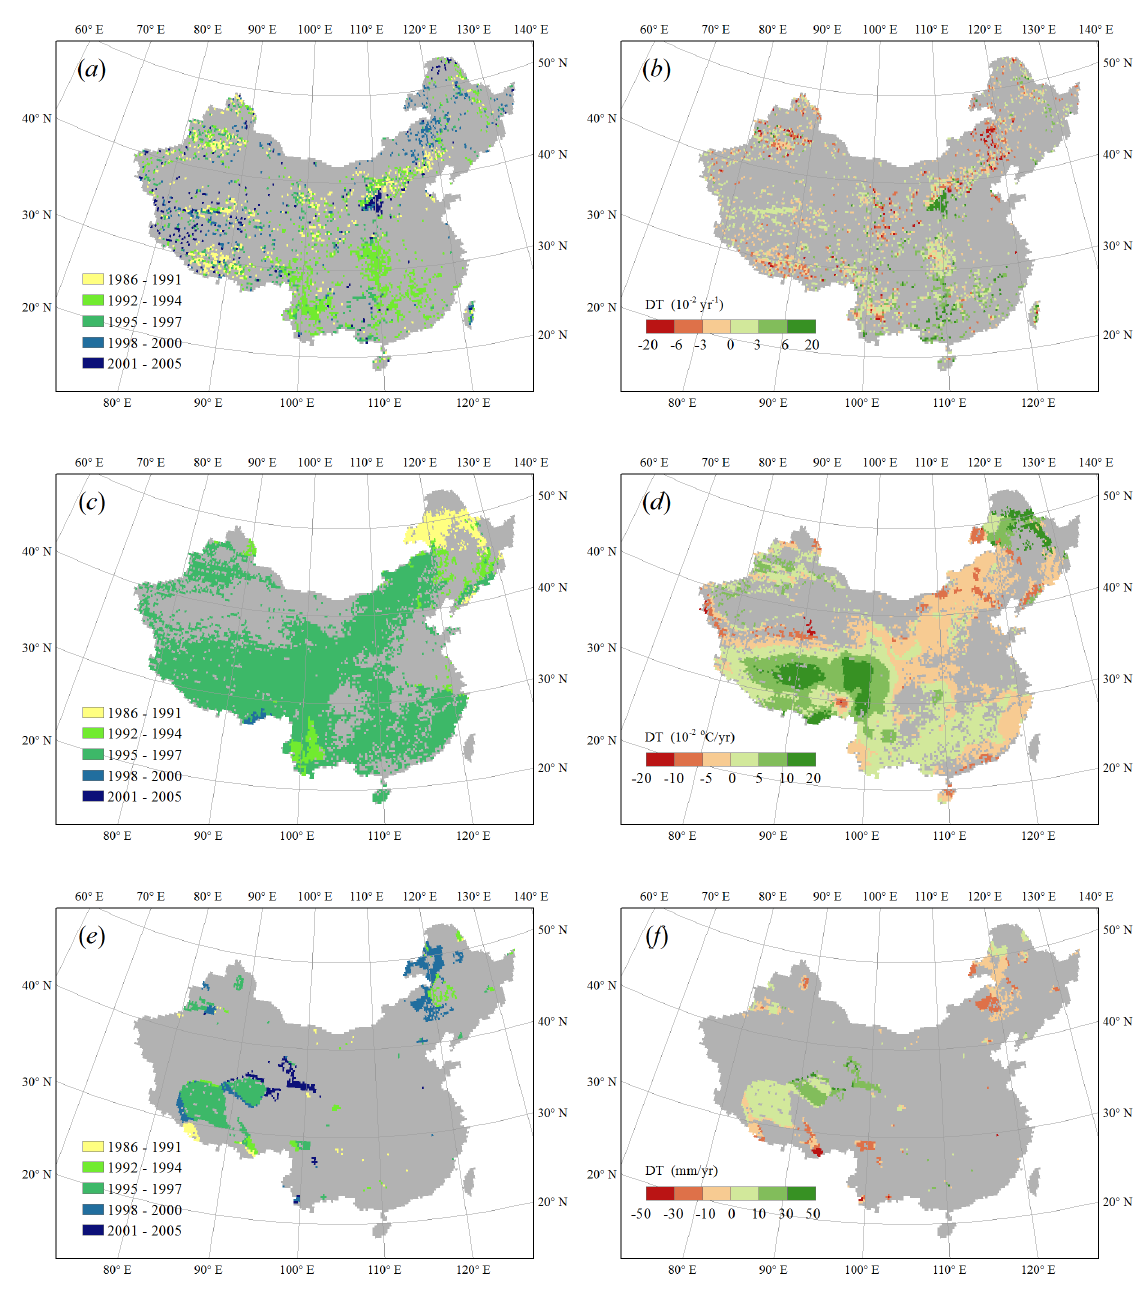
Figure 10. Spatial distribution of abrupt change points in the growing season mean ( a ) NDVI; The difference of trends (DT) before and after abrupt change points in the growing season mean ( b ) NDVI; ( c ) air temperature; ( d ) air temperature; ( e ) precipitation and ( f ) precipitation. DT was calculated by trends after abrupt change points minus trends before abrupt change